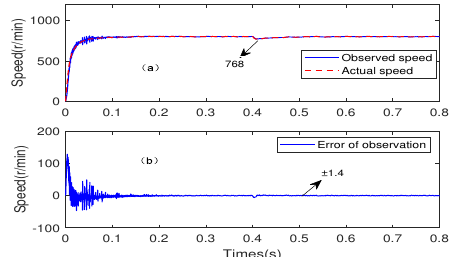
Figure 18. The speed response of VPDPI regulator under 800 r/min. ( a ) Observed speed and actual speed. ( b ) Estimation error curve.